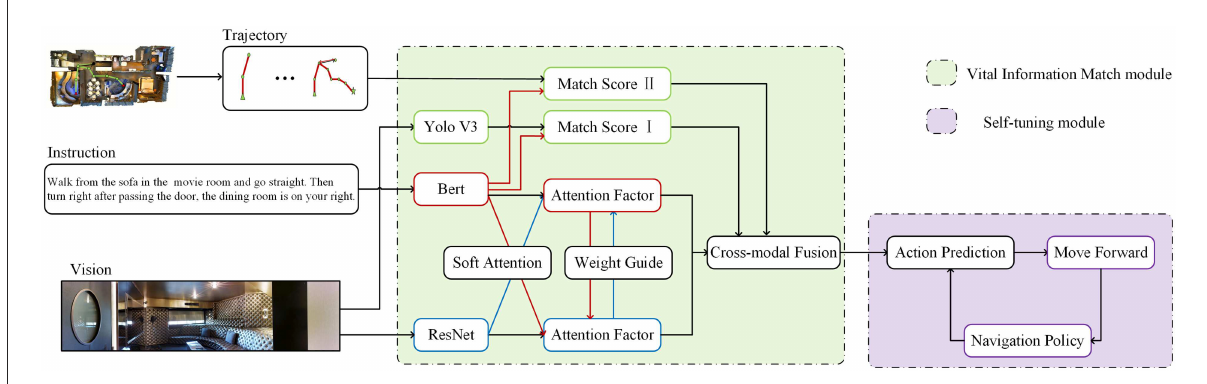
FIGURE3 Schema of the proposed architecture for VLN. The input instruction is vision, instruction, and trajectory. The VIM-Net consists of a Vital Information match module, a cross-model guide module, and a self-tuning